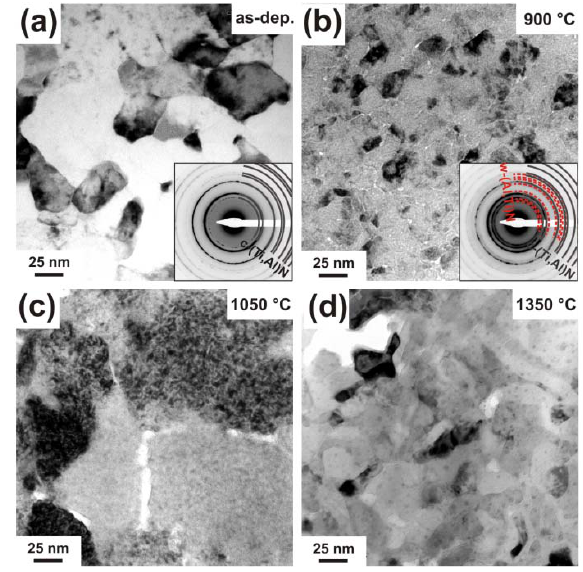
Figure 3. Plan view TEM micrographs of c-Ti after annealing to (b) 900 °C, (c) 1050 °C, and (d) 1350 °C. The small insets in (a) and (b) show their corresponding SAED